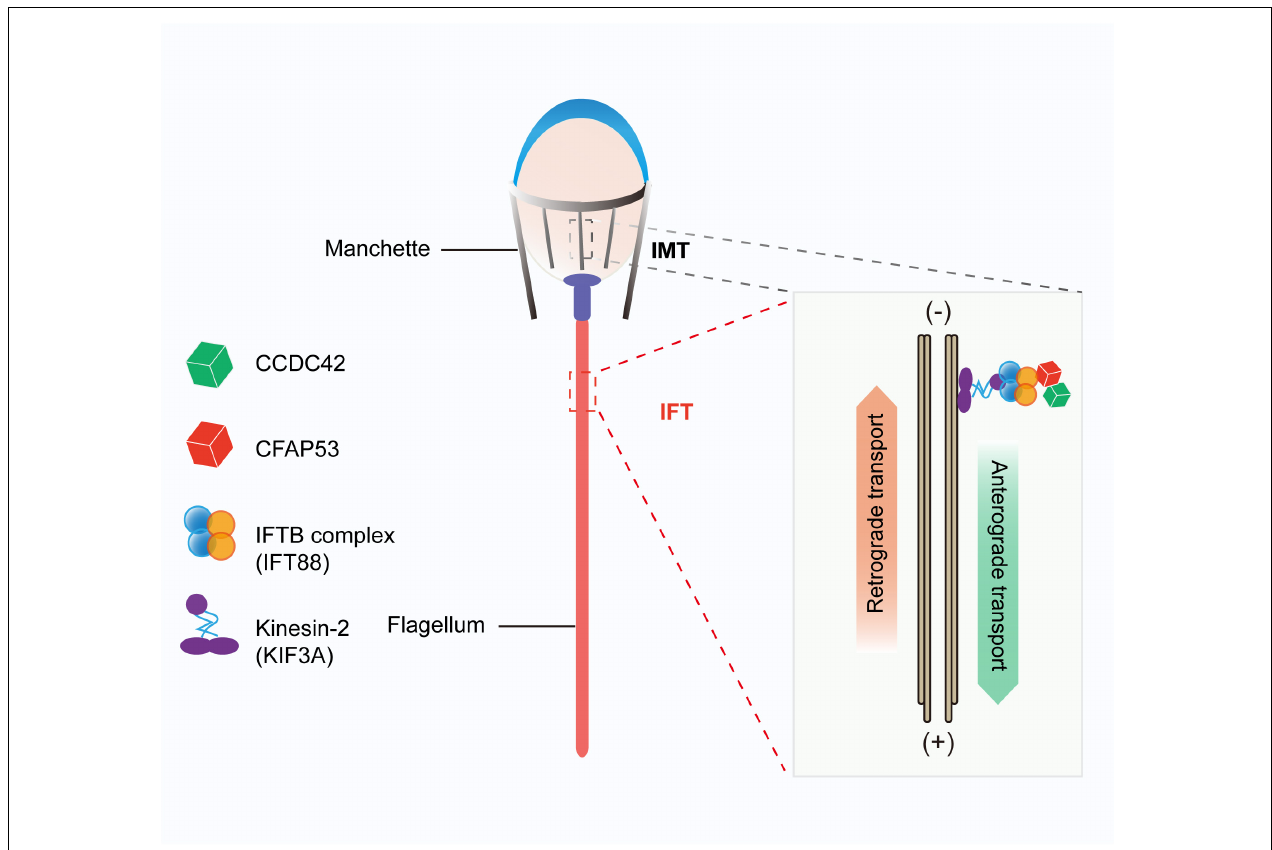
FIGURE 7 | Proposed model for the functional role of CFAP53 during flagellum biogenesis. CFAP53 works as a cargo protein, and it is involved in the stabilization of other cargo proteins, such as CCDC42, that need to be transported to the developing sperm tail. During transport, CFAP53 interacts with IFT complex B member IFT88 and kinesin-2 motor subunit KIF3A for targeting to its